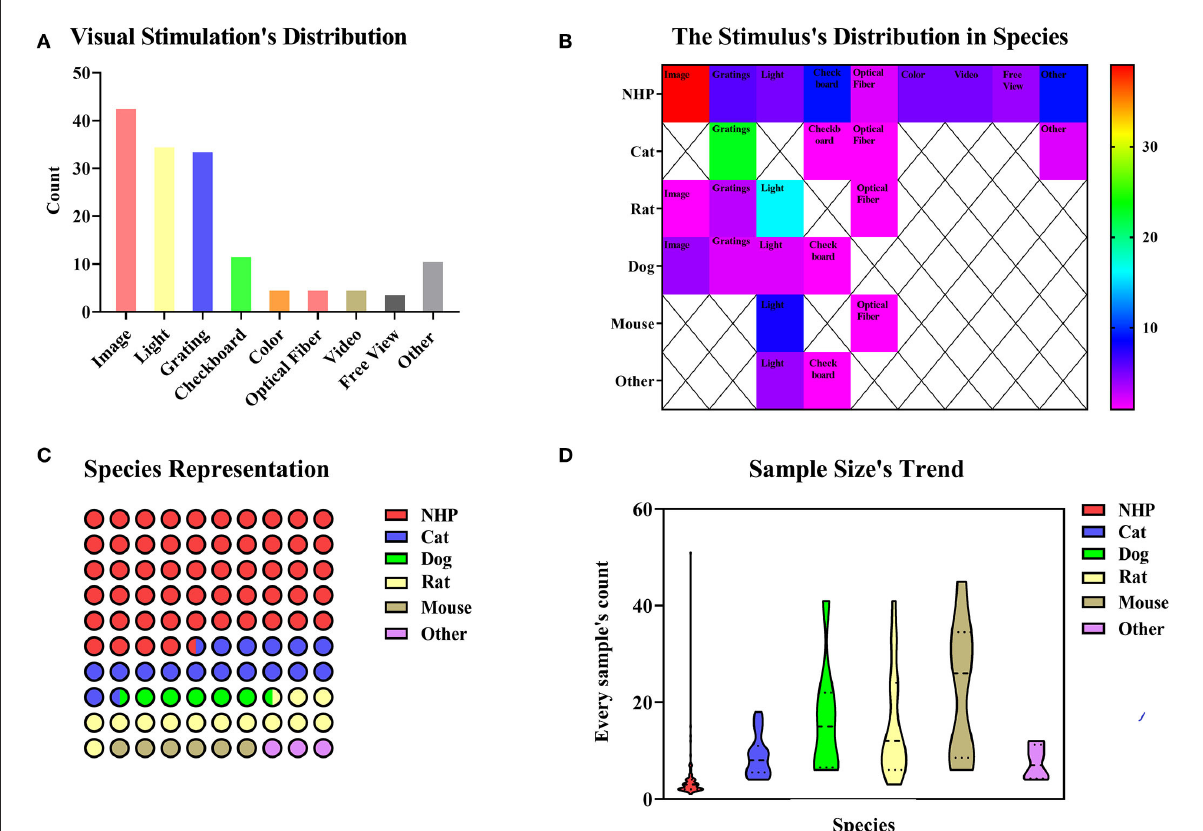
FIGURE4 (A) In total of 154 paradigms of visual stimulation collected, we divided the methods of the stimulus into image (n = 43, 27.92%), light (n = 35, 22.72%), gratings (n = 34, 22.08%), checkboard (n = 12, 7.79%), color (n = 5, 3.25%), optical fiber (n = 5, 3.25%), video (n = 5, n = 5, 3.25%) and freeview (n = 4, 2.60%). Some experiments covered several different methods of the stimulus (n = 11, 7.14%). (B) Image is mainly used for NHP among the collected paradigms. Species distribution and sample size’s trend. The color bar means the number of studies. (C) Animal representation in the collected paradigms. NHP, cats, and rats are the principal animals used for visual stimulation. (D) A number of animals used per fMRI study. NHP studies are carried out with fewer animals, whereas studies involving mice involve larger